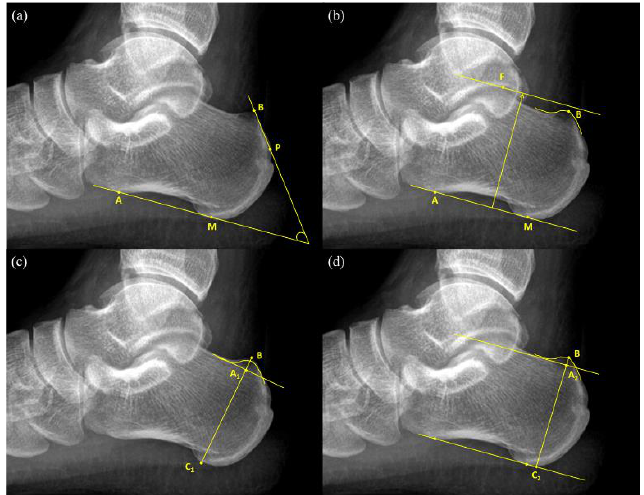
Figure 1. Radiographic measurement of Haglund’s deformity ( a ) Fowler-Philip angle = Angle be- tween AM and BP ; ( b ) Heneghan-Pavlov parallel pitch lines; ( c ) Haglund’s height = BA 1 ; Haglund’s height ratio = BA 1 /BC 1 ; ( d ) Bump height = BA 2 ; bump-calcaneus ratio = BA 2 /BC 2